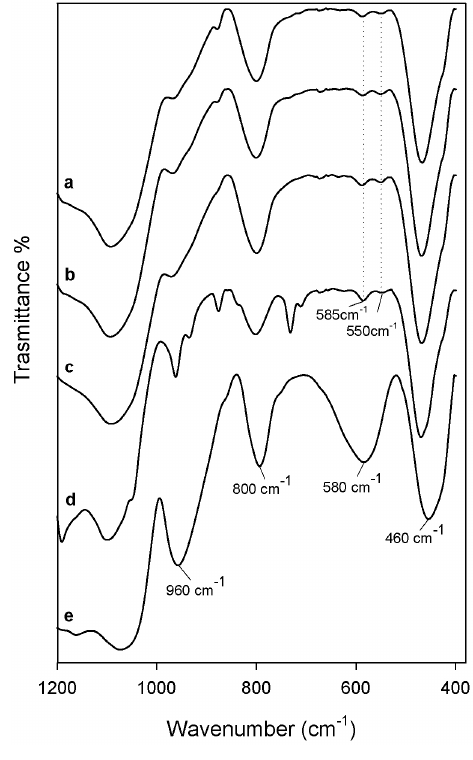
Figure 6. Representative FTIR spectra of ( a ) SiO 2 /PCL 6 wt % /CGA 20 wt % ; ( b ) SiO 2 /PCL 12 wt % /CGA 20 wt % ; ( c ) SiO 2 /PCL 24 wt % /CGA 20 wt % ; ( d ) SiO 2 /PCL 50 wt % /CGA 20 wt % after 21 days of exposure to SBF; and ( e ) SiO 2 /PCL 12 wt % /CGA 20 wt % before soaking in SBF.